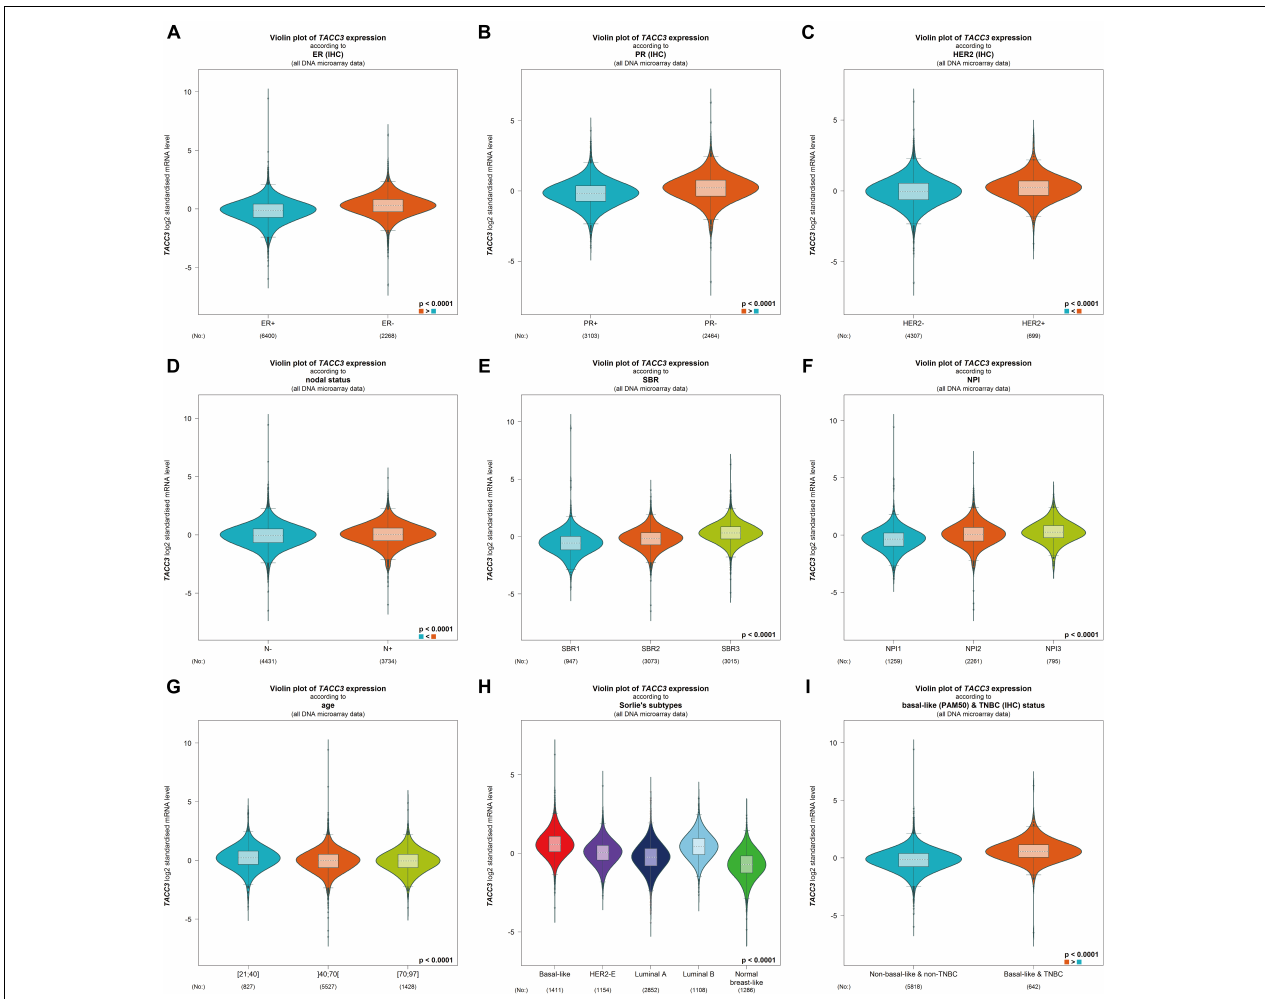
FIGURE 3 | The relationship between the TACC3 expression levels in patients with breast cancer was addressed using bc-GenExMiner v4.4 based on different types of clinical characteristics parameters. (A–C) receptor status (ER + vs. ER -, PR + vs. PR -, HER2 + vs. HER2 -, (D) nodal status (N + vs. N-), (E) SBR (SBR1, SBR2, and SBR3), (F) NPI (NPI1, NPI2, and NPI3), (G) age ( ≤ 51 and > 51 years), (H) subtypes (basal-like, HER2-E, luminal A, luminal B, and normal breast-like), and (I) triple-negative status (TNBC vs. Not